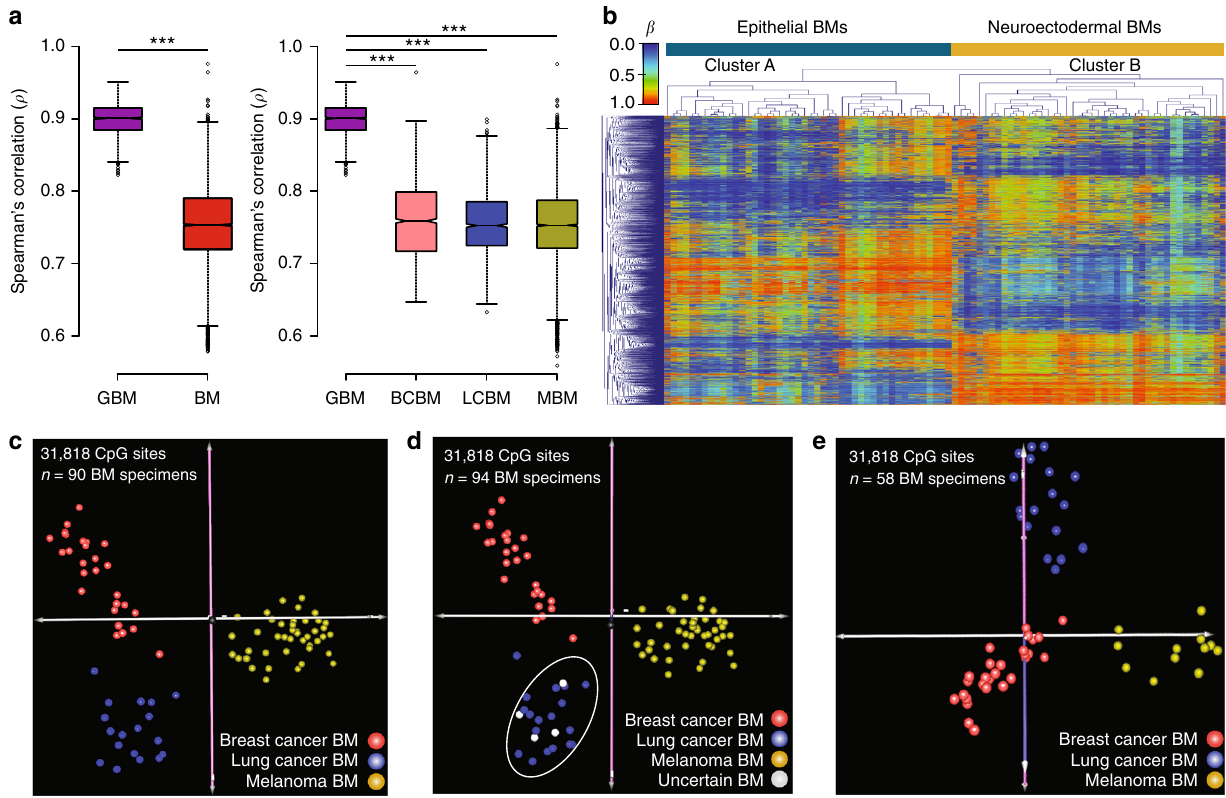
Fig. 2 DNA methylation differences among brain metastases. a Boxplot representing overall Spearman ’ s ρ correlation coef fi cients among brain tumors. The left plot includes all the GBM specimens ( n = 60, mean ρ = 0.90 ± 0.06) and all the BM specimens ( n = 94, mean ρ = 0.77 ± 0.02). The right plot describes the overall Spearman ’ s ρ correlation coef fi cient among BM specimens with anatomical pathology con fi rmed tumor of origin (BCBM n = 28, LCBM n = 18, and MBM n = 44). The top and bottom of each box represent the fi rst and third quartile, respectively; the internal line represents the median. ***Spearman ’ s correlation test; P -value < 0.001. b Unsupervised hierarchical clustering using Euclidean distance of the top 5000 most variable genomic regions. c PCA using 31,818 CpG sites with signi fi cant (ANOVA, Bonferroni adjusted P -value < 0.05; Supplementary Data 4) differential DNA methylation level among BM with anatomical pathology con fi rmed tissue of origin ( n = 90). d PCA using the differentially methylated region including four BM specimens with uncertain primary tumor of origin ( n = 94). e PCA including BM specimens from female patients ( n =